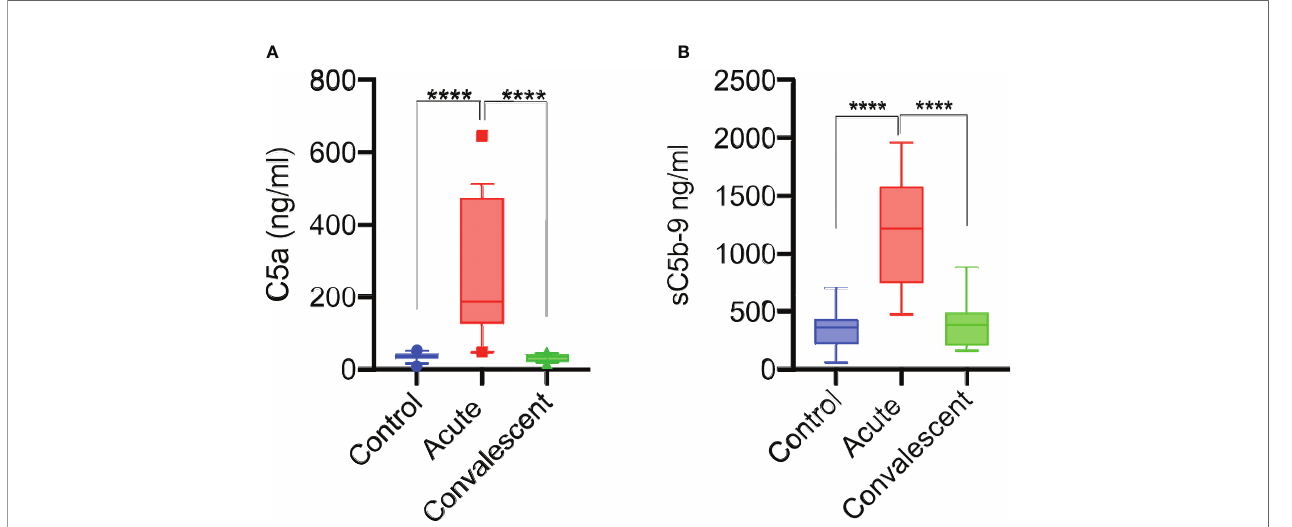
FIGURE 5 | Complement system is activated during acute COVID-19 infection. Anaphylatoxin C5a levels in patients sera increase during acute disease and return to normal on recovery (n = 25) (A) . sC5b-9 levels were also signi fi cantly increased during the acute phase (n = 25) of severe COVID-19 and returned to levels seen in NHS (n = 14) of healthy blood donors and sera taken from convalescent patients (B) . Results were analysed using 1-way ANOVA, with Dunnett ’ s correction for multiple comparisons. **** p <